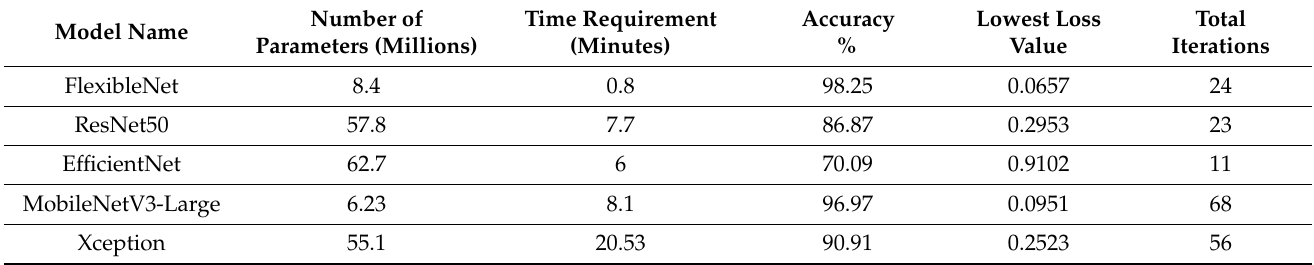
Table 6. Summary of the outcomes of the experiments using an image resolution of 128 ×